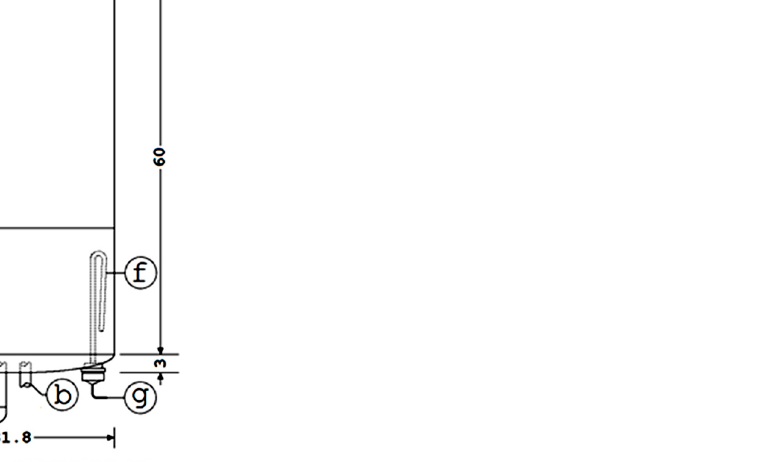
Figure 4. Perspective view showing an approximate placement of temperature digital sensors through barrels and ambient (A) box containing DAQ for data logging, (B) flipped barrel as a stand for DAQ box, (C) ball valve, (D) air and water vapor mixture inlet, (E) air and water vapor mixture outlet furnished for manual piping, (F) hose piped to (Part: E). 2.3. Experimental Design In this research study, there were two main types of composting mass aeration: passive and forced aeration. The composting mass in each barrel was subjected to eight different treatments as listed in Table 1, wherein each barrel 60 kg (loose filling) of com- posting mass was prepared and in the case of using an additive (charcoal). The materials for composting were taken from a pile at the end of June 2019 and kept on the house roof for nat- ural drying until the beginning of the experimental work on 2 December 2019. To achieve some kind of homogeneity, the 60 kg composting mass was divided into six amounts of 10 kg each which contains 0.5 kg of either charcoal or manure and 9.5 kg of DSR that was mixed thoroughly and likewise in the case of using cow dung. There was an intervention to reduce the C/N ratio on the 1st day of composting period before operating the system and after mixing additives with DSR in case of barrels which were experimentally de-